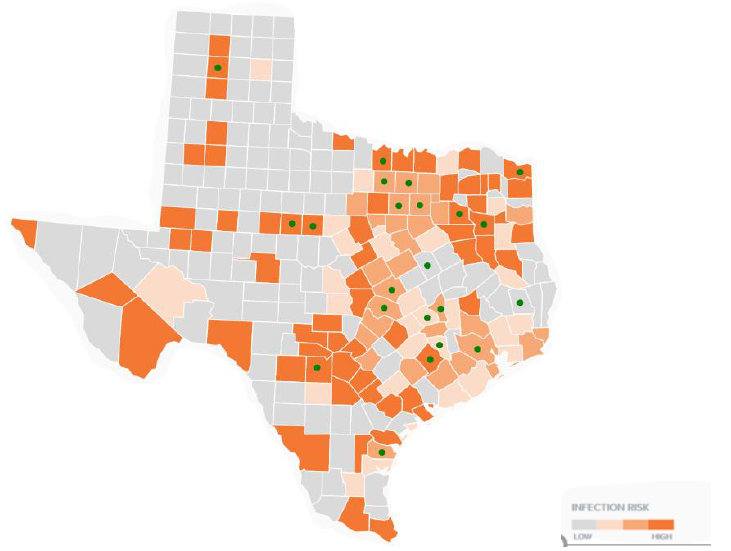
Figure 4. 2018 canine ehrlichiosis and TTS respondent tick bite encounters. (Data Source: Companion Animal Parasite Council, Ehrlichiosis Canine Report, 2018; Raw data source, IDEXX Laboratories and Antech Diagnostics.)